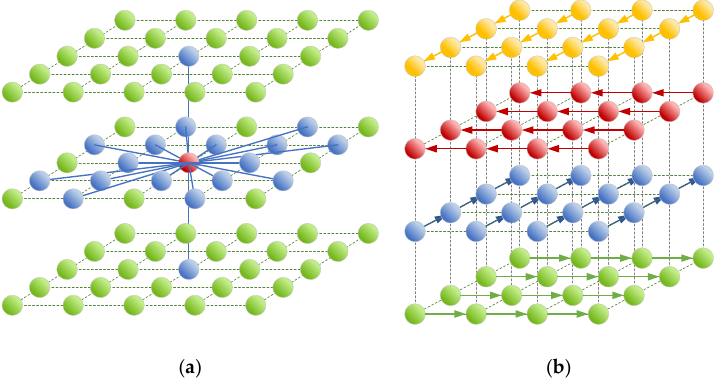
Figure 6. ( a ) Grid showing the connection between a node and its 18 neighbors. ( b ) Representation of the multiple grids superposed in the same plane where each grid allows travel in a single direction.